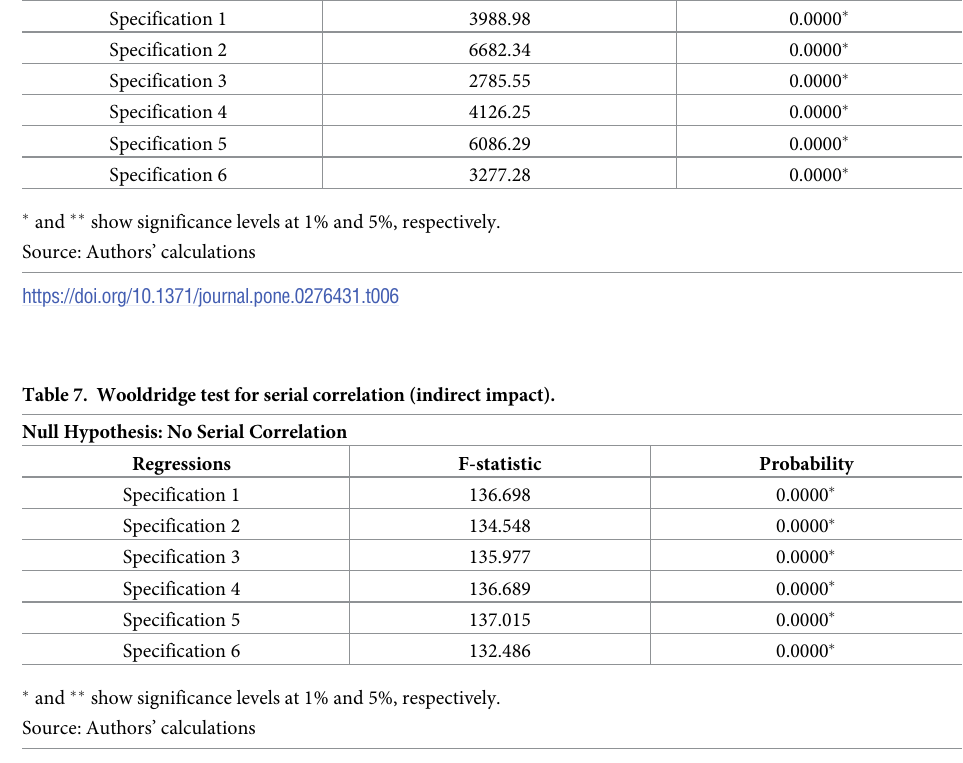
Table 6. Wald test for heteroscedasticity (indirect impact). Null Hypothesis: Homoscedasticity